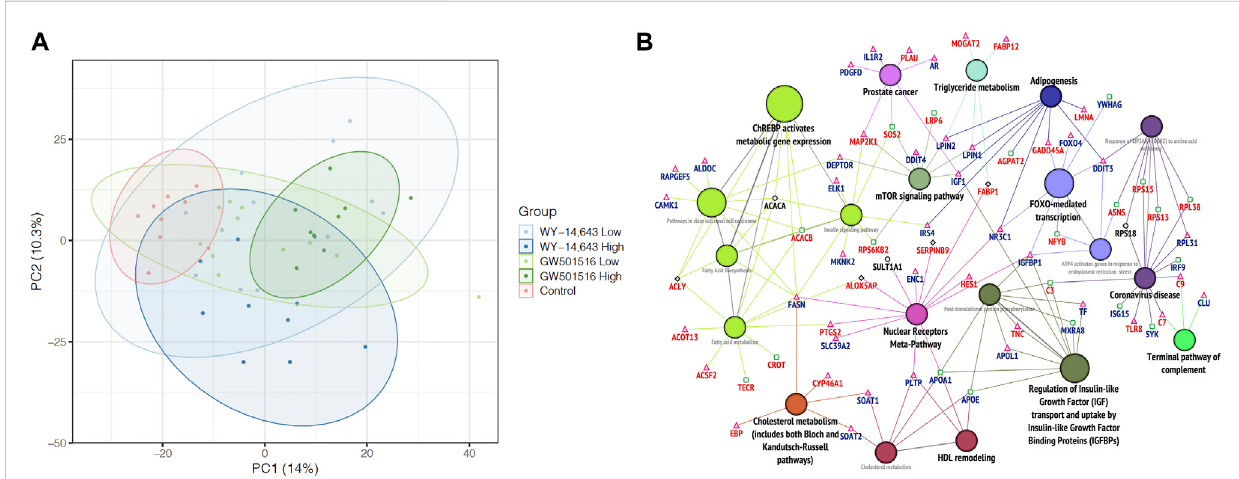
FIGURE 7 Multi-omics analyses. (A) Principal component analysis of differentially affected genes, proteins, and lipids. The graph shows data points and 95% con fi dence ellipses for each treatment group. (B) Integrative analysis of pathways and networks using merged lists of differentially expressed genes and proteins inAtlanticcod liver after WY-14,643 treatment, using ClueGo in Cytoscape. Signi fi cantly enriched networks(adjusted p -value < 0.05)generated usingClueGowithWikipathway,KEGGandReactomedatabasesareshown.Gene/proteinsymbolsshowninredandblueindicateupregulationand downregulation, respectively. Triangle, square and diamond symbols, represent transcripts, proteins and both (transcripts and proteins), respectively. For a similar analysis of GW501516 treatment, see Supplementary Figure